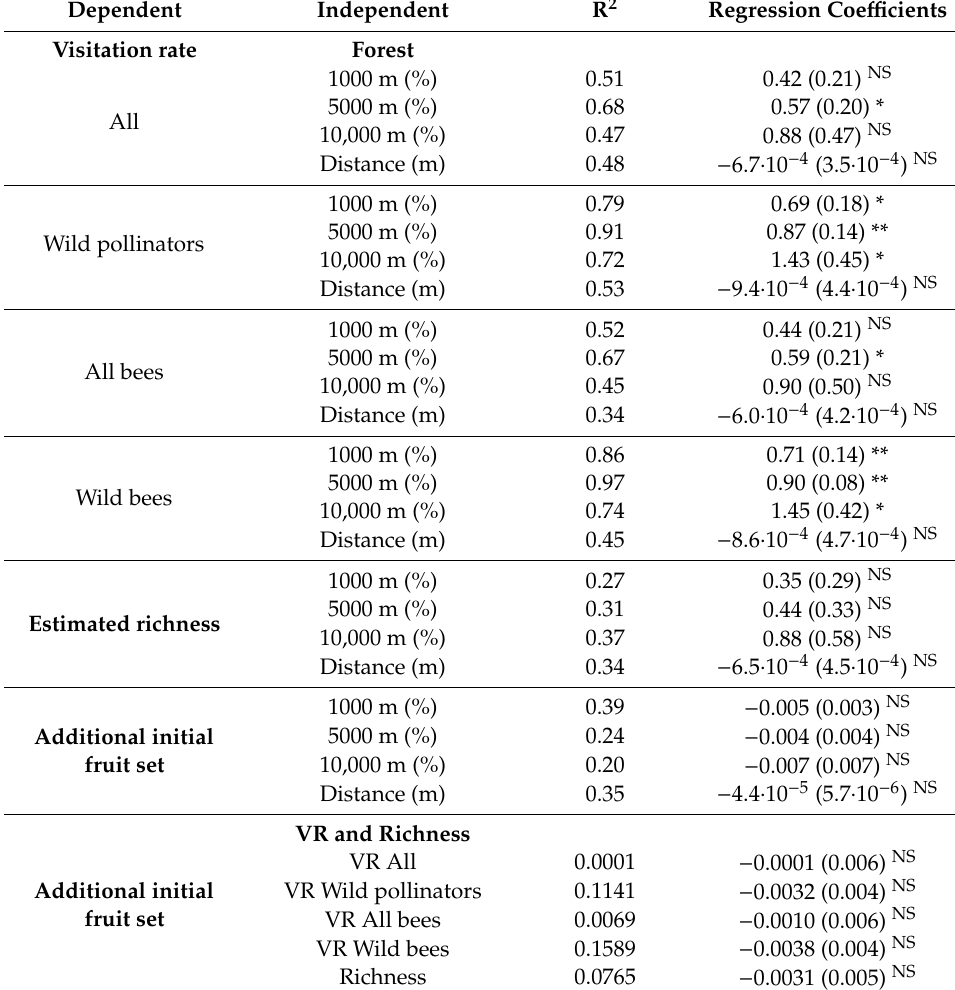
Table 2. Linear regression models of pollinator visitation rates (VR) (visits / flower / 15 min), richness and additional fruit set with pollinators as a function of four measures of evergreen forest e ff ect: % of evergreen forest in the surrounding landscape within di ff erent distances to the study site (1, 5 and 10 km) and the distance to nearest forest patch from each study site (in meter). For each model, we also report the coe ffi cient of determination (R 2 ) and the regression coe ffi cients with standard error. NS p > 0.05, * p < 0.05, ** p <